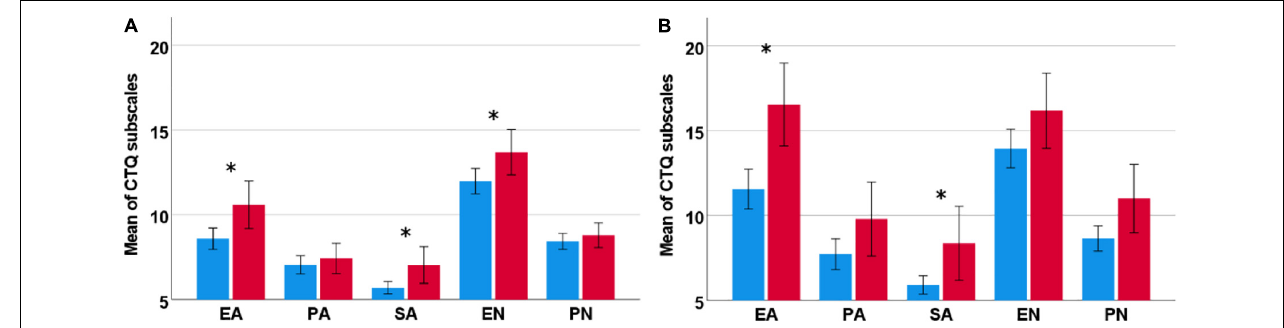
FIGURE 2 | Significant sex differences for the main diagnoses AUD (left) and CUD (right) regarding mean values of the sum scores per subscale of the CTQ. (A) In AUD (left), females (red) reported significantly more severe CM for emotional and sexual abuse, and emotional neglect. (B) In CUD (right), females (red) reported significantly more severe CM for emotional and sexual abuse. CTQ, Childhood Trauma Questionnaire; EA, emotional abuse; PA, physical abuse, SA, sexual abuse, EN, emotional neglect; PN, physical neglect. Error bars are displayed at a 95% confidence interval. ∗ Significant sex difference. TABLE 4 | Severity of childhood maltreatment in relation to symptoms of anxiety, depressiveness, and perceived stress for the overall patient group, and separately by sex. BDI